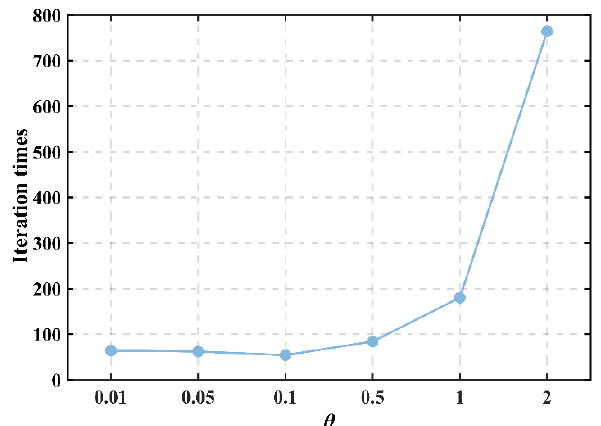
Figure 11. The iteration times by the proposed algorithm under different θ values.